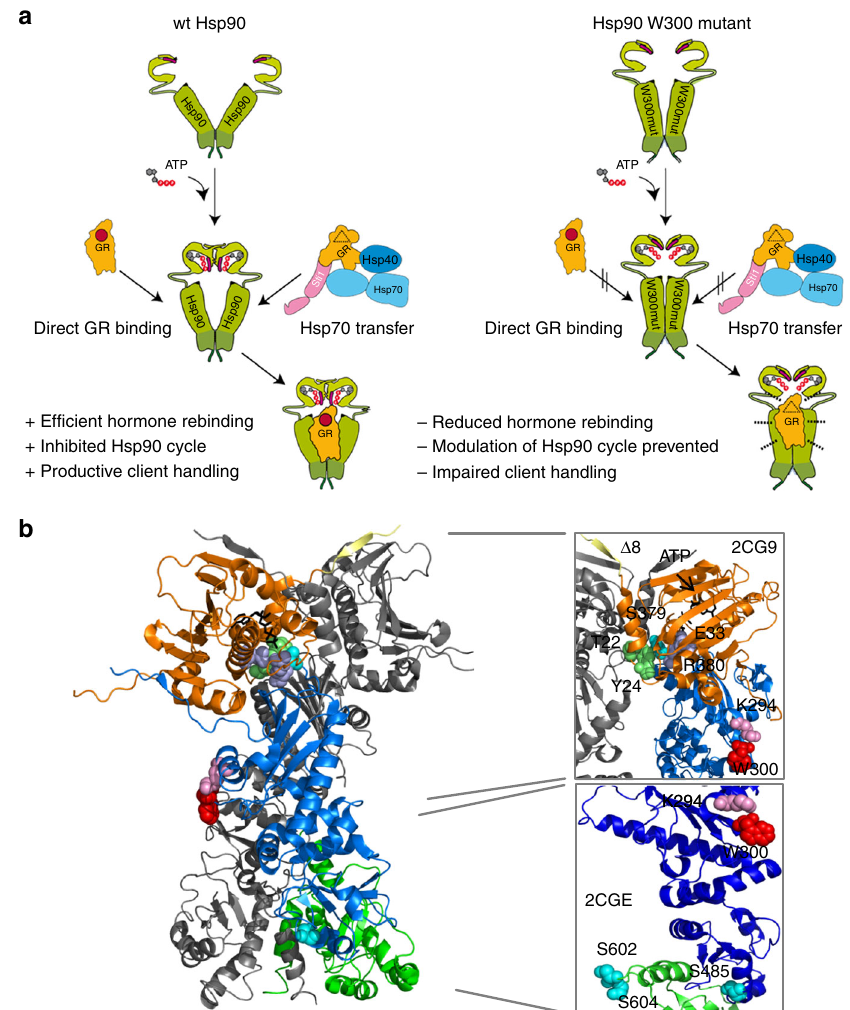
Fig. 6 In fl uence of W300 on the conformational cycle of Hsp90. a With the help of W300, wt Hsp90 forms a semi-closed conformation induced by the GR that ensures high af fi nity binding, client transfer from the Hsp70 system, ef fi cient hormone rebinding, establishment of the cycle inhibiting effects of the GR and thereby productive client handling. By forming signi fi cantly altered conformations, the Hsp90 W300 mutants show reduced induction of hormone rebinding, an altered association with the GR-LBD and become insensitive to the inhibitory effects of GR on the conformational cycle dynamics as implied by the dotted lines, resulting in impaired client handling of Hsp90. b Mapping of the different switch point positions in Hsp90; Switch point positions were mapped on the crystal structure of Hsp90 (PDB ID: 2CG9) and Hsp90-MC (PDB ID: 2CGE). T22 and Y24 20, 46 are colored in lime. S379, S485, S602 and S604 24 are colored in cyan. S602 and S604 are not resolved in the full-length crystal structure and are therefore mapped on the Hsp90-MC structure. R380 and E33 are shown in light purple and the fi rst eight N-terminal residues ( Δ 8) in yellow 47 . W300 is colored in red and K294 in pink. Boxes show blow-ups from the closed Hsp90 (2CG9) and the 90-MC construct